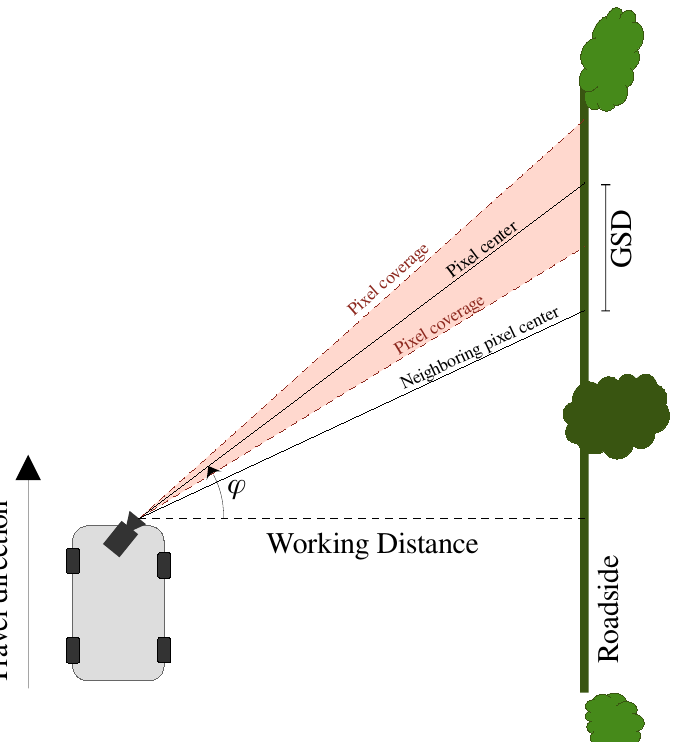
Figure 1. Ground sampling distance (GSD) at specific camera orientation relative to the driving direction, and thus the roadside. The red filled area illustrates the area covered by a single pixel. The closer the the orientation angle ϕ is to 90°and the greater the working distance (WD), the greater GSD. With a larger GSD, fewer details can be captured in the images, which is also illustrated in Figure